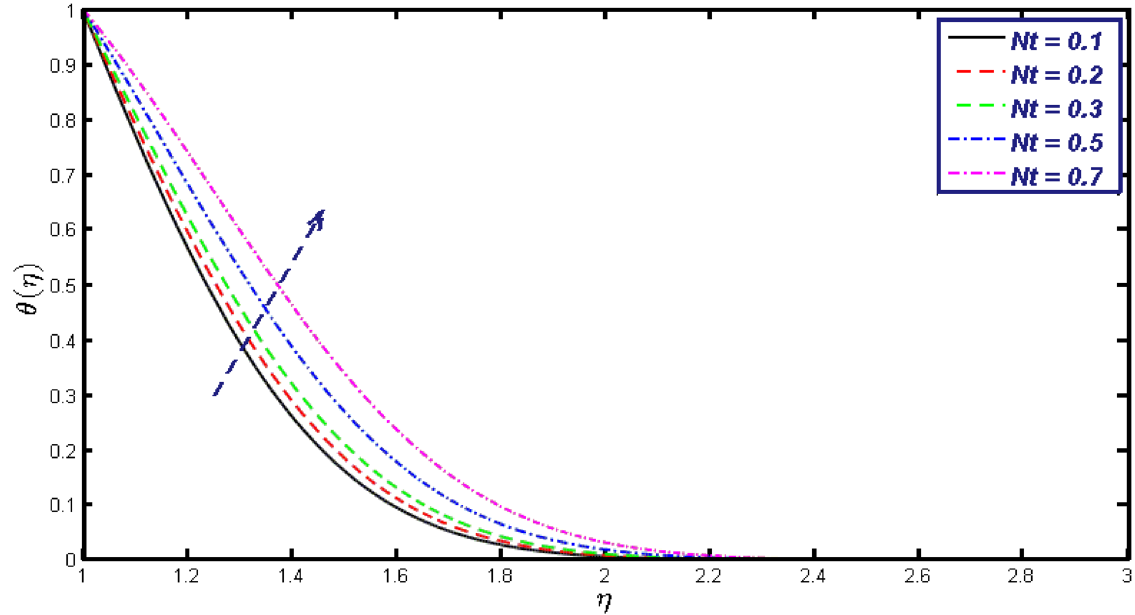
Figure 13. θ(η) field for different values of Nt .